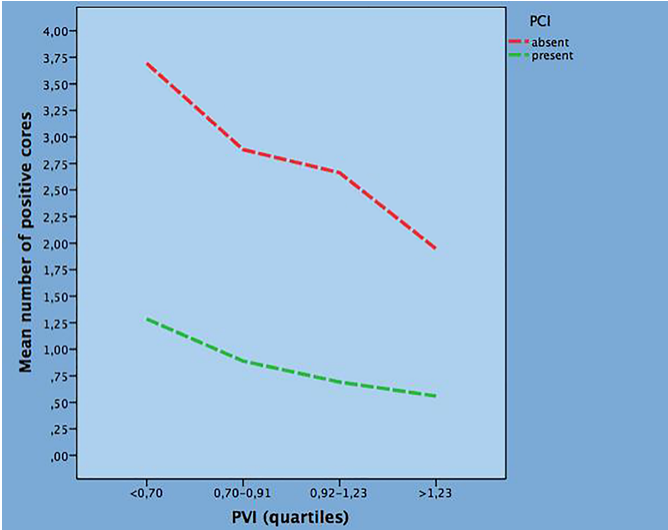
Figure 3 - Bivariate model predicting the mean number of positive cores by prostatic chronic inflammation (PCI) and prostate volume index (PVI)